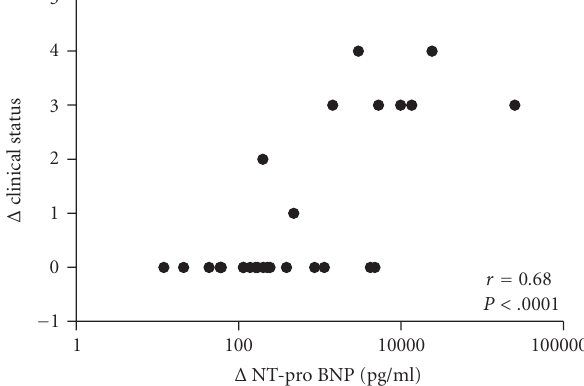
Figure 2: Correlation between change in clinical status and NT- proBNP (log 10, pg/mL).